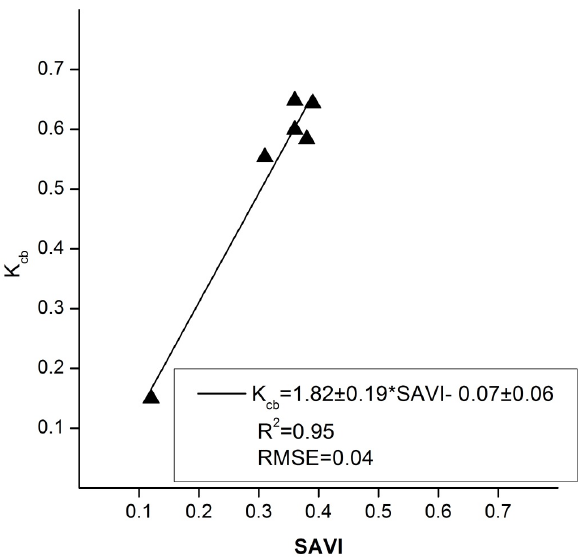
Figure 6. K cb -SAVI linear relationship for the studied apple orchard. K cb values at effective full cover correspond to the apple canopy without weeds.